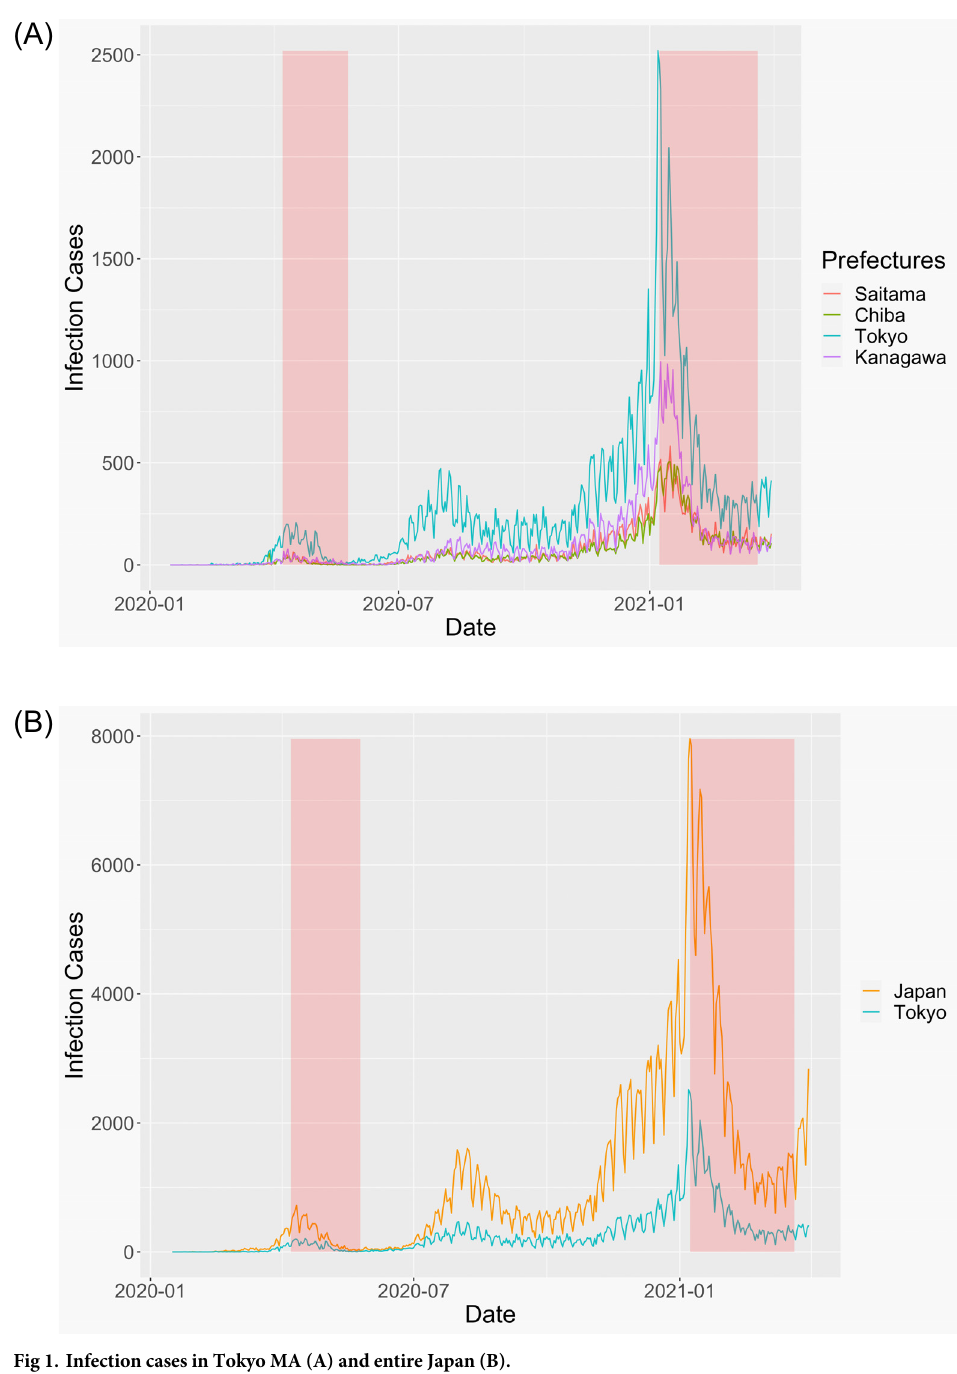
third was from April 25, 2021, but the affected areas were limited. The end of the periods differ across prefectures. The fourth lockdown started from August 1, 2021, as infection cases increased during the Tokyo Olympics. The first quasi-lockdown was from April 7 to May 25, 2020. From April 7, eight prefectures, including Tokyo, Kanagawa, Chiba, and Saitama prefec- tures, imposed a quasi-lockdown. From April 16, this lockdown spread nationwide. This